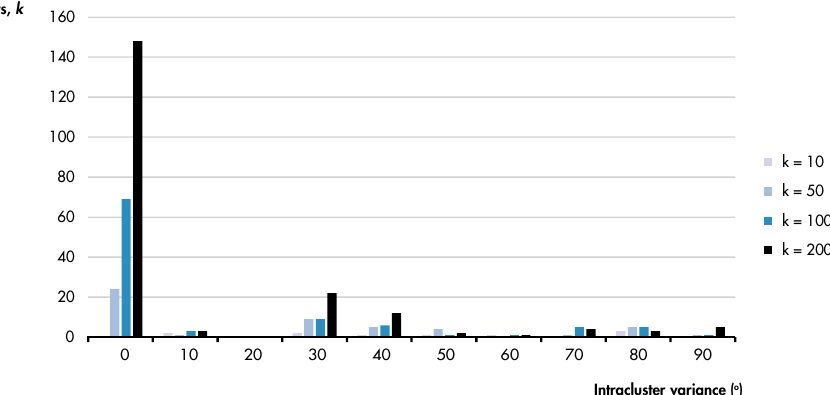
Figure 12. The frequency histogram of the intracluster variance, when joints are grouped into multiple values of clusters, k